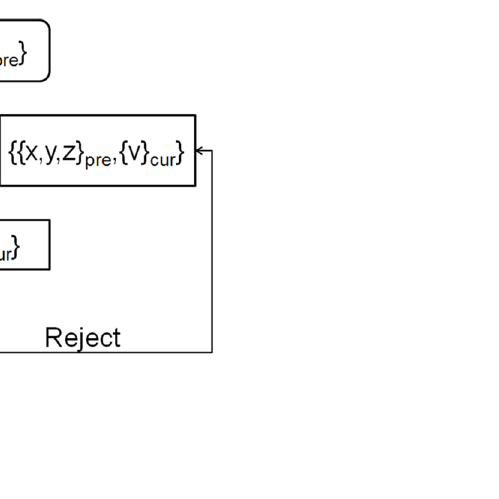
have the same initial structures. The frame of the hybrid MD-MC simulations is presented in Fig 2.